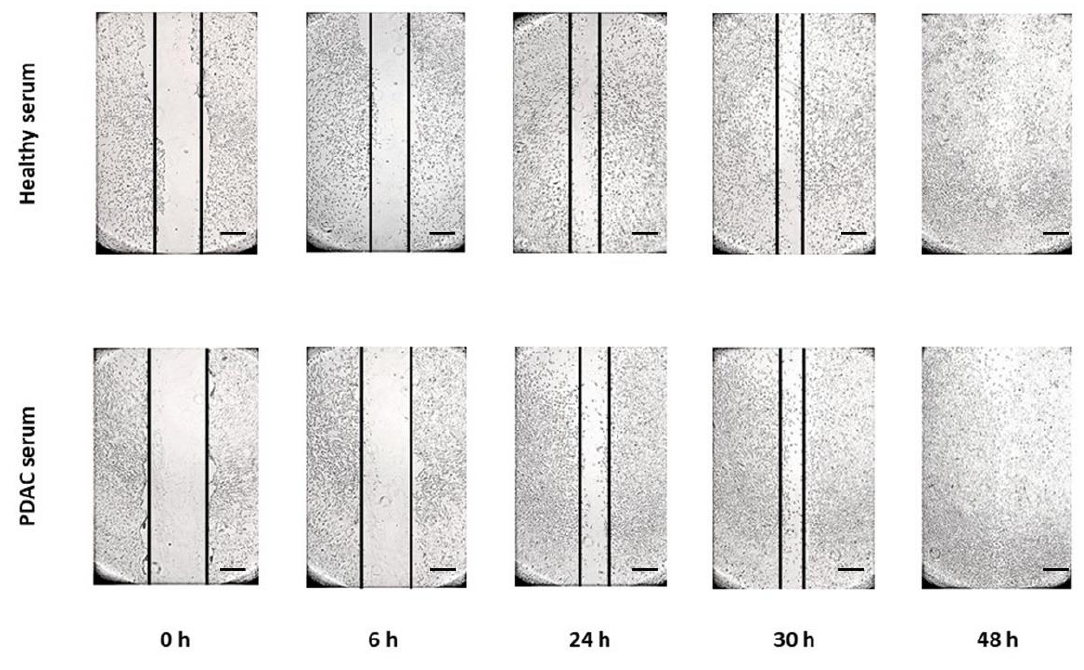
Figure 3. The representative wound healing migration assay for hTERT-HPNE cell line treated with healthy or PDAC sera. Scale bar = 400 μm.